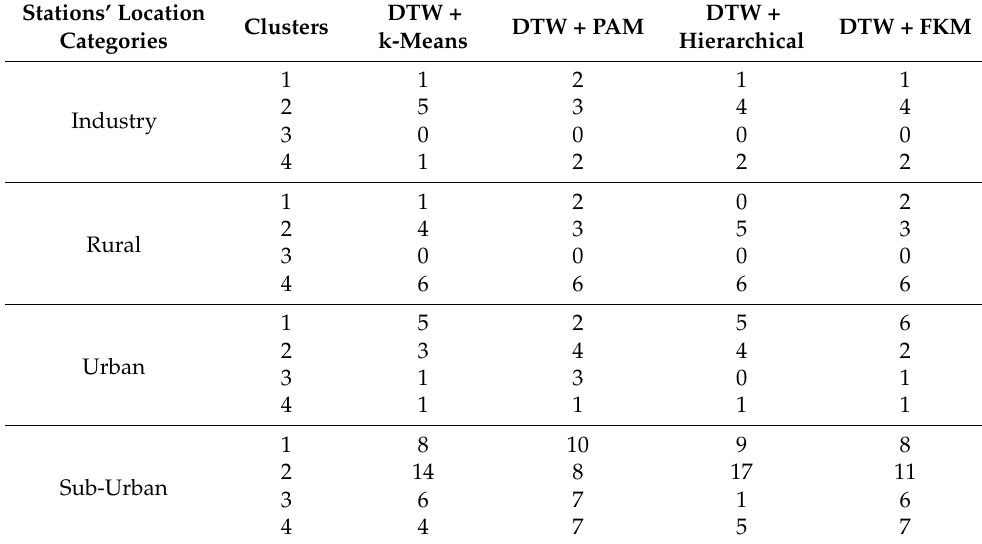
Table 3. Crosstable of the number of stations between clusters formed for each clustering algorithm with the stations’ location categories of the PM 10 daily average time series